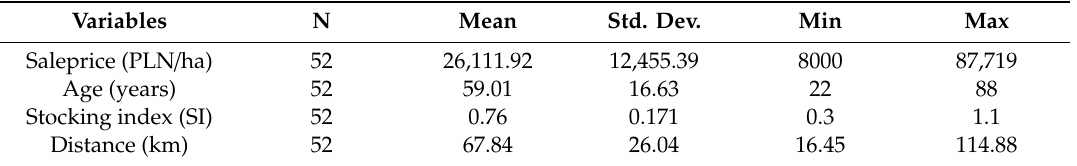
Table 1. Descriptive statistics of forest